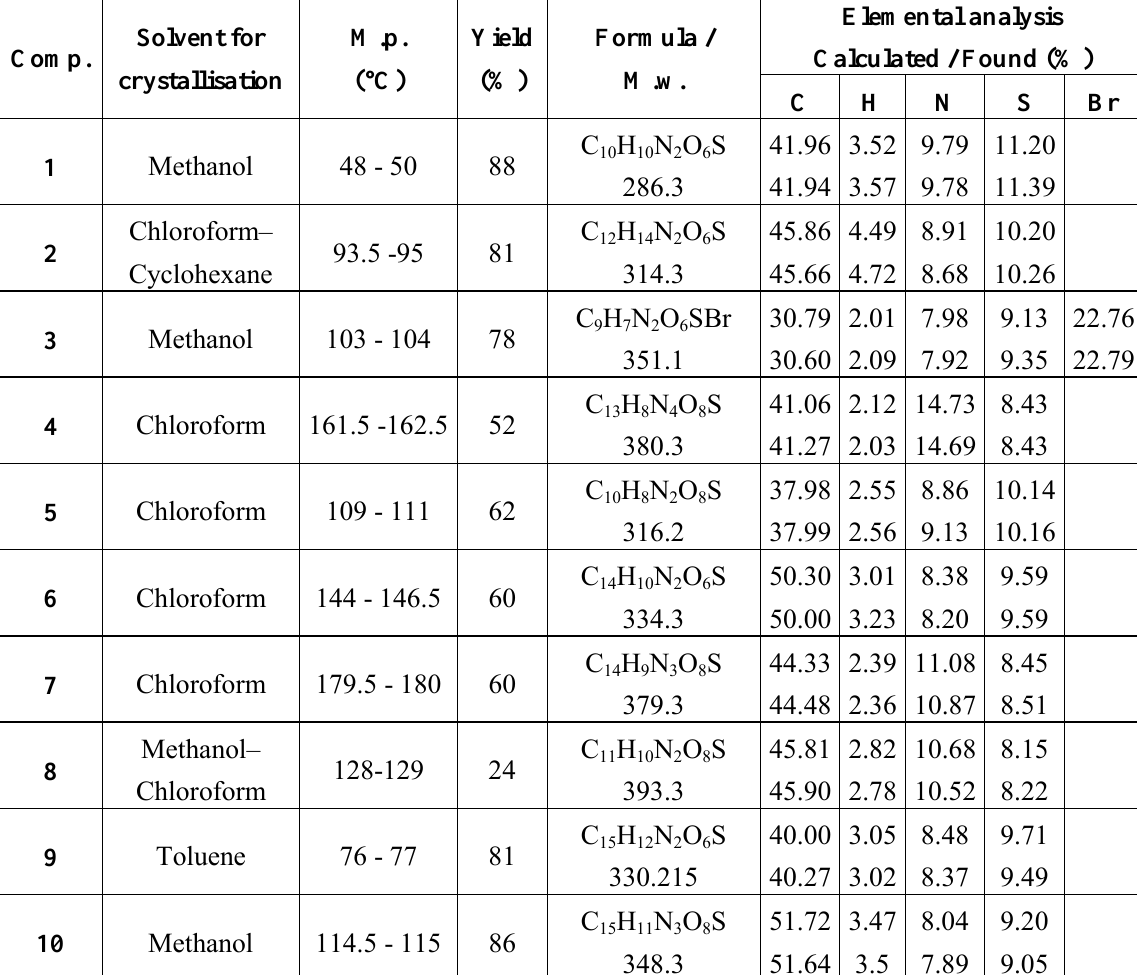
Table I. Melting points and elemental analyses of compounds 1 - 10